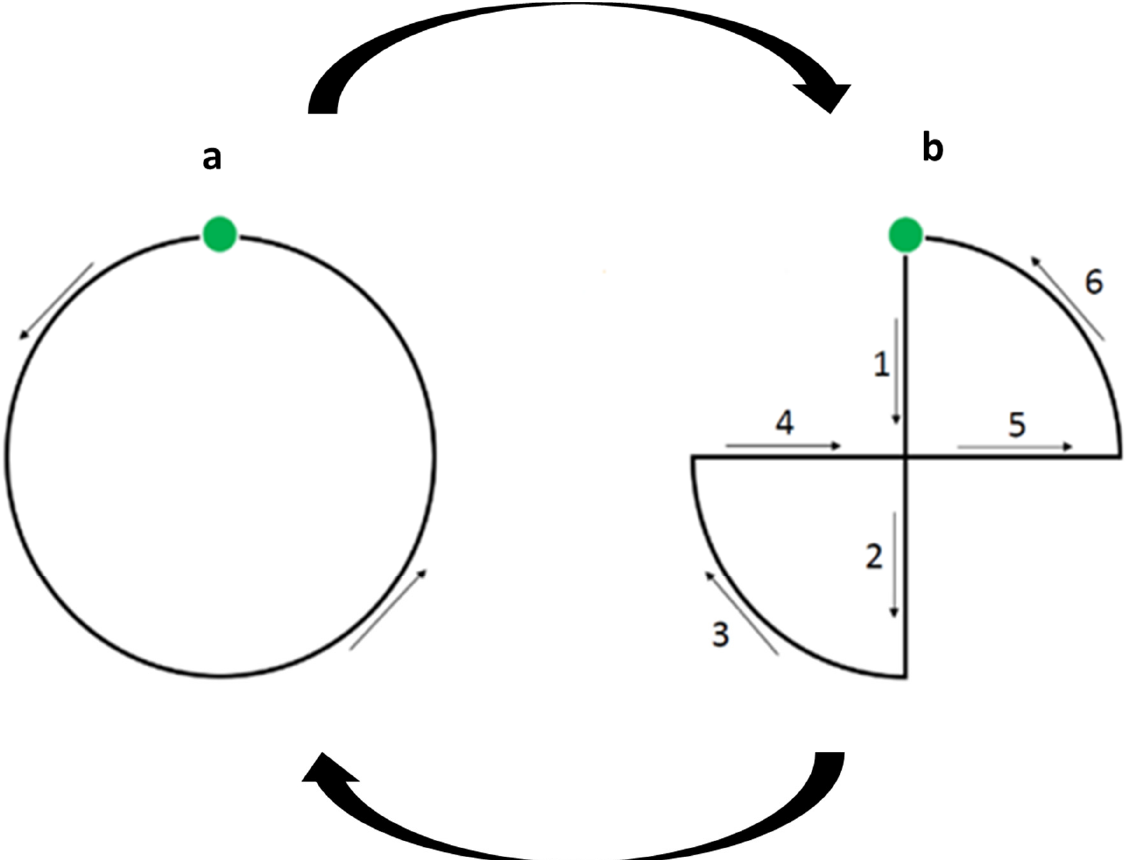
Figure 1. Visual stimulus used during the non-social visual attention test, adapted from [26]. The light was moved repeatedly, regularly, and continuously over 20 s using a computer program, starting anticlockwise ( a ) to continue over a “8” shape ( b ). Six cycles were broadcasted during each 2 min test.